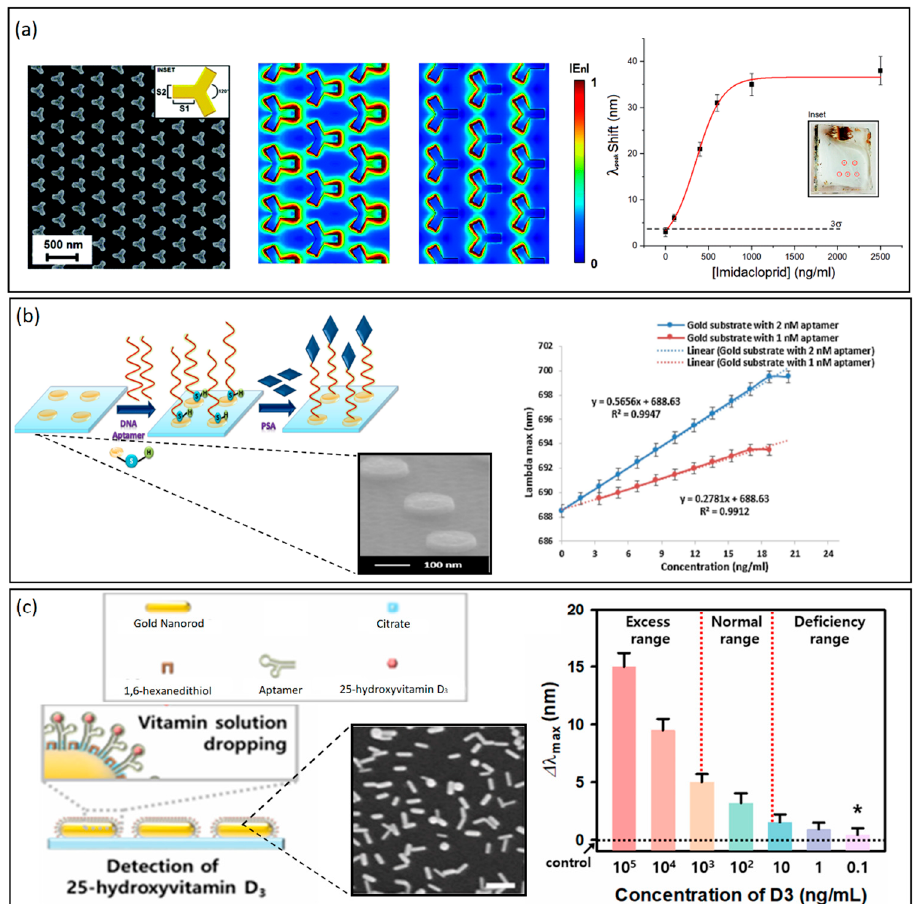
Figure 3. ( a ) From left to right: a plasmonic 2D nanostructure based on a periodic arrangement of iso-Y gold NPs, electric field enhancement simulations, and detection of imidacloprid pesticide achieving an LOD of 1 ng/mL. Adapted with permission from Ref. [106]. Copyright (2021), Royal Society of Chemistry. ( b ) From left to right: detection scheme of PSA through aptamers covalently bound to gold atoms. SEM image of gold nano-disks on a glass substrate. A linear relationship between lambda max shifts and the change of PSA concentration for two gold substrates having different concentrations of DNA aptamers. The dotted lines are the theoretical curves, while the continuous lines are the experimental curves. Adapted with permission from Ref. [108], Copyright (2018), Elsevier. ( c ) From left to right: detection scheme of 25-hydroxyvitamin D3, by gold nanorods (AuNRs) immobilized on a glass substrate. SEM image of AuNRs. 25-Hydroxyvitamin D3 detection by AuNRs based on lambda max shifts for a wide range of concentrations (0.1–105 ng/mL). Adapted with permission from Ref. [112], Copyright (2021),